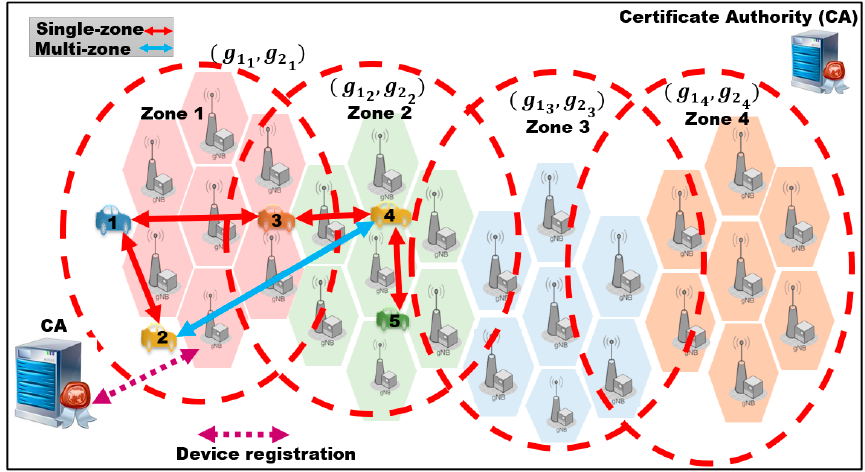
Figure 2. Single-zone and multi-zone communication in the 5G-V2X network model time for the three proposed authentication methods, and six previous related methods for single-zone and multi-zone scenarios.